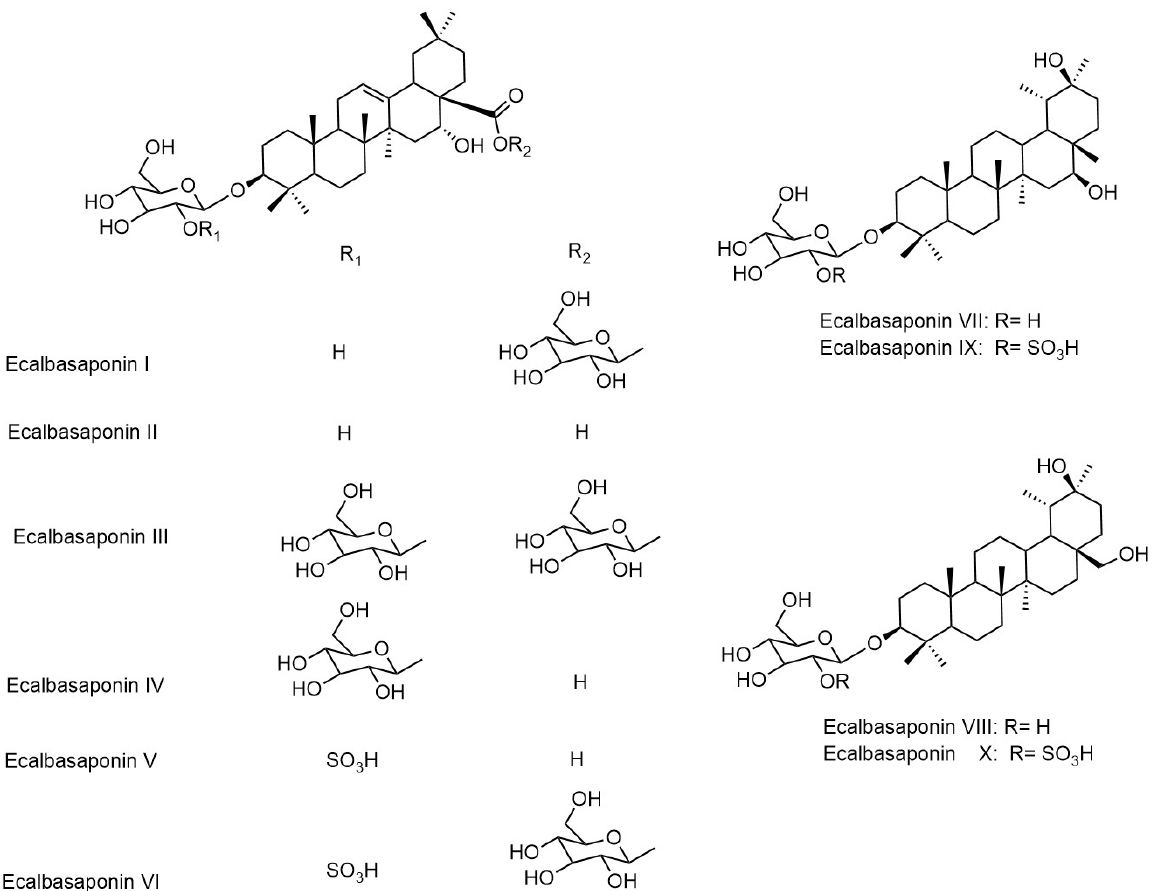
Figure 4. Structures of main triterpene saponins.